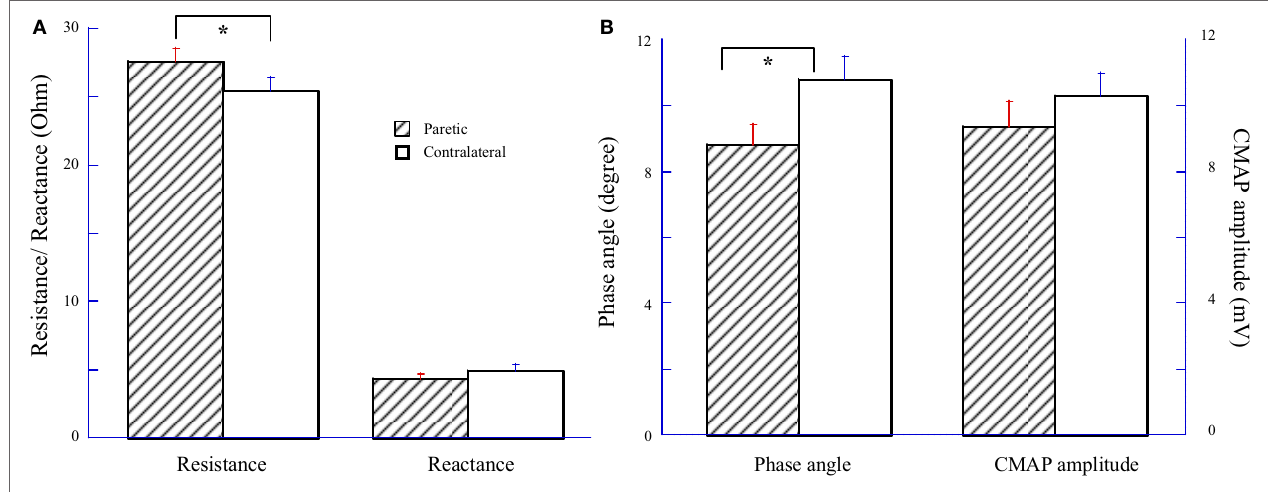
FigUre 1 | Comparisons of electrical impedance myography and compound muscle action potential (CMAP) between paretic and contralateral muscles. (a) Resistance (R) and reactance (X). (B) Phase angle ( θ ) and CMAP amplitude.